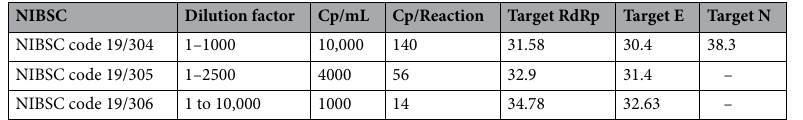
Table 3. Results comparison of our assay (MOLgen SARS CoV-2) with three commercially available RT-PCR assays detecting